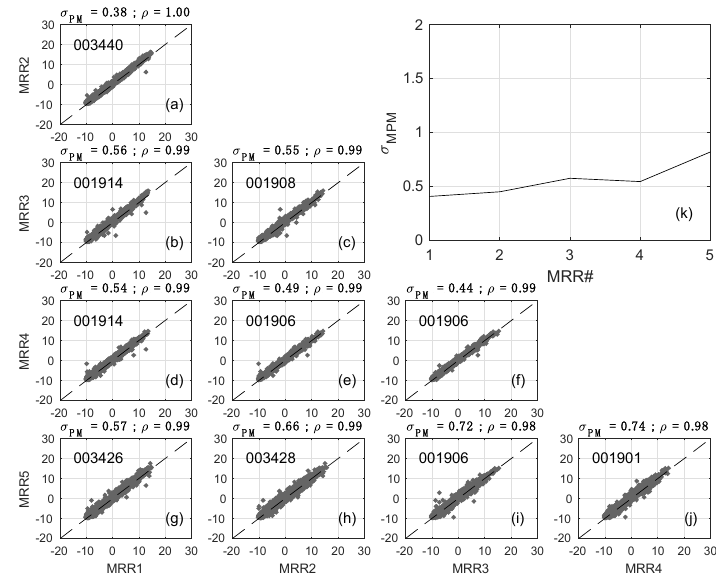
Figure 8. ( a )–( j ): scatterplot of rainfall rate (dBR) calculated from five MRR disdrometers. The corresponding values of the measurement error ( σ ) from paired measurements and the correlation coefficient ( ρ ) are shown on the top of each panel. The standard deviation of the measurement noise ( σ ) from multiple paired measurements are shown in ( k ).